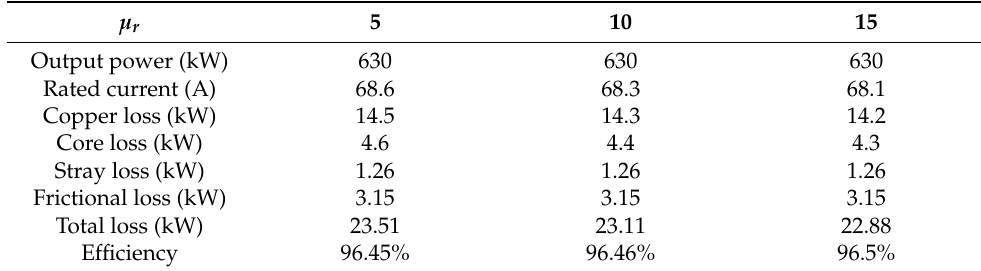
Table 6. Motor performance at rated